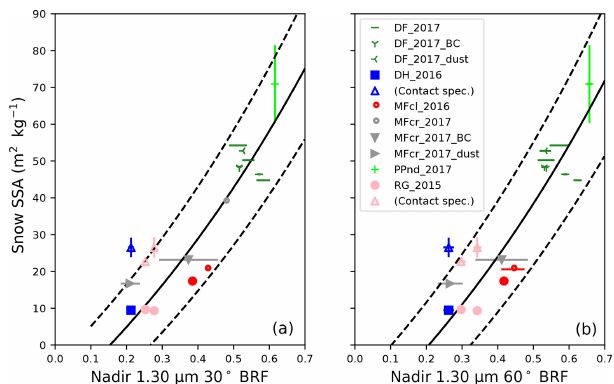
Figure 5. Snow 1.3µm BRF to SSA exponential regressions. Mark- ers with standard error bars represent SSA measured with X-CT ∗ and scattered against nadir 1.30µm 30 ◦ (a) and 60 ◦ (b) BRFs mea- sured by the NERD. Solid curves represent exponential regression functions, and dashed curves represent standard errors of the regres- sions such that at 30 ◦ viewing, α = 88 . 7 ( ± 9 . 50 ) m 2 kg − 1 and β = − 103m 2 kg − 1 , and at 60 ◦ viewing, α = 91 . 7 ( ± 10 . 13 ) m 2 kg − 1 and β = − 113m 2 kg − 1 . ∗ Hollow triangles (blue, depth hoar; pink, rounded grains) represent snow SSA measurements derived from contact